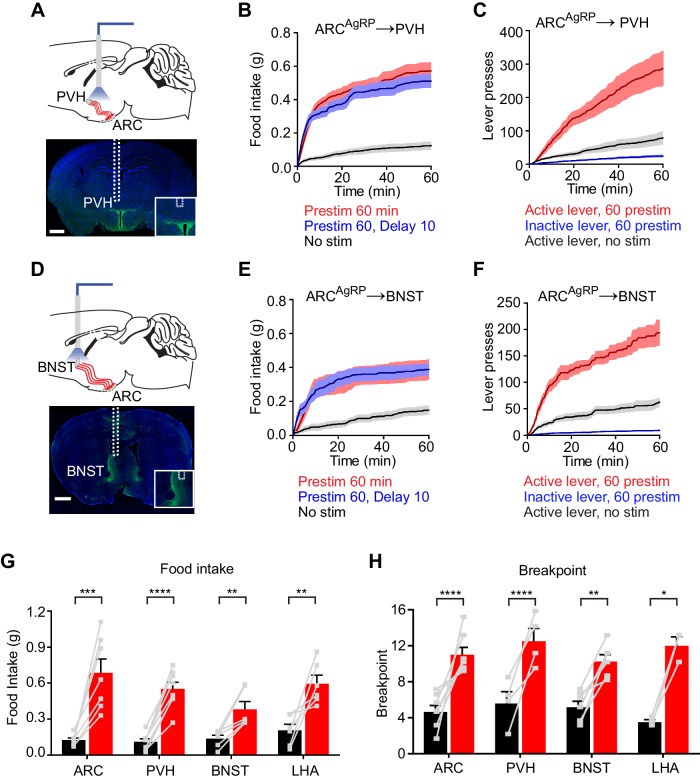
Projections of AgRP neurons to PVH, BNST or LHA are sufficient to prime feeding behavior.(A) Optical fiber placement above AgRPARC→PVH. (B–C) Plots of cumulative food intake (B) and lever presses (C) evoked by prestimulating AgRPARC→PVH axonal terminals. Filled areas indicate S.E.M. (D) Optical fiber placement above AgRPARC→BNST. (E–F) Plots of cumulative food intake (E) and lever presses (F) evoked by prestimulating AgRPARC→BNST axonal terminals. Filled areas indicate S.E.M. (G) 60 min food intake evoked by 60 min prestimulation of AgRPARC, AgRPARC→PVH, AgRPARC→BNST and AgRPARC→LHA (red) and corresponding nostim controls (black). (H) Breakpoint in 60 min progressive ratio 3 task reached by animals with 60 min prestimulation of AgRPARC, AgRPARC→PVH, AgRPARC→BNST and AgRPARC→LHA (red) and corresponding nostim controls (black). Asterisks on top of brackets indicate significance levels for comparisons with the respective protocols, using one-way-ANOVA with Holm-Sidak’s correction for multiple comparisons (****p≤0.0001, ***0.0001<p≤0.001, **0.001<p≤0.01, *0.01<p≤0.05, ns p>0.05). ARC food intake n = 8; ARC PR3 n = 7; PVH food intake n = 8; PVH PR3 n = 4; BNST food intake n = 6; BNST PR3 n = 6; LHA food intake n = 6; LHA PR3 n = 3.